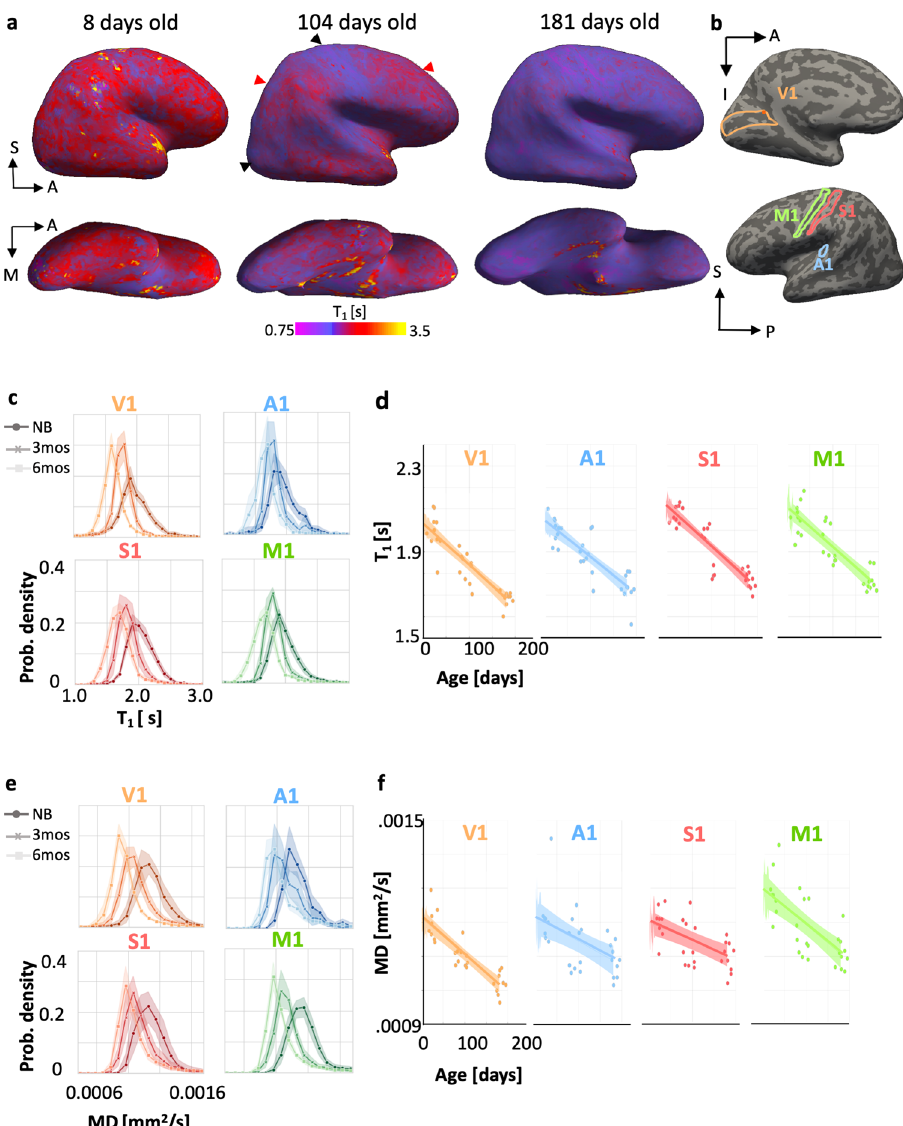
Fig. 1 Primary sensory cortices are not fully developed at birth but show extensive microstructural tissue growth during the fi rst 6 months of life. a Right hemisphere sagittal (top) and ventral-temporal (bottom) T 1 maps in units of seconds [s] displayed on an in fl ated cortical surface of an example infant across time. Left to right: cortical T 1 at 8 days (newborn), 104 days (~3 months), and 181 days (~6 months) of age ( red/yellow: higher T 1 ; purple : lower T 1 ). b Primary sensory-motor areas 35 : V1, A1, M1, and S1 shown on the cortical surface of this infant. c T 1 distributions across voxels of each area show a leftward shift from newborns (darker colors) to 6-month-olds (lighter colors). Solid lines : mean distribution; Shaded region : standard error of the mean across 10 infants at each timepoint. NB: newborn; 3 mos: 3-month-old; 6 mos: 6-month-old. Darker colors indicate younger infants. d T 1 linearly decreases with age in primary sensory-motor areas. Each dot : mean T 1 per area per infant. Line: Linear mixed model line fi t. e – f Same as in c,d for mean diffusivity (MD). Shaded portions represent 95% con fi dence intervals. For panels c – f , N total = 30, 10 infants at each time point (newborn, ~3-month-old, [2.29 ± 0.027s] (Fig. 2c-right hemisphere, Supplementary Fig. 5-left hemisphere). In the ventral stream, it increases from V1v [2.01± 0.026s] to PHC2 [2.21±.027s] (Fig. 2f-right hemisphere, Supplementary Fig. 5-left hemisphere). In both streams, we observed that T 1 at birth plateaued before the fi nal retinotopic area of each stream. That is, estimated T 1 at birth plateaued at IPS1 in the dorsal stream and at VO1 in the ventral stream. To test if there are developmental differences across visual areas of each stream and hemisphere, we ran additional LMMs Fig. 2e, Supplementary Table 4, all stats). Second, LMM estimates across T 1 data from all visual areas of a stream, with factors of age [in days], area, and hemisphere. The model comparison showed of T 1 at birth showed a systematic increase in T 1 at birth ascending the hierarchy of each processing stream. In the dorsal that an LMM that allows both the intercepts and slopes to vary stream, T 1 at birth increases from V1d [2.0 ± 0.028s] to IPS3 across areas best fi t the data (Methods). In both ventral and